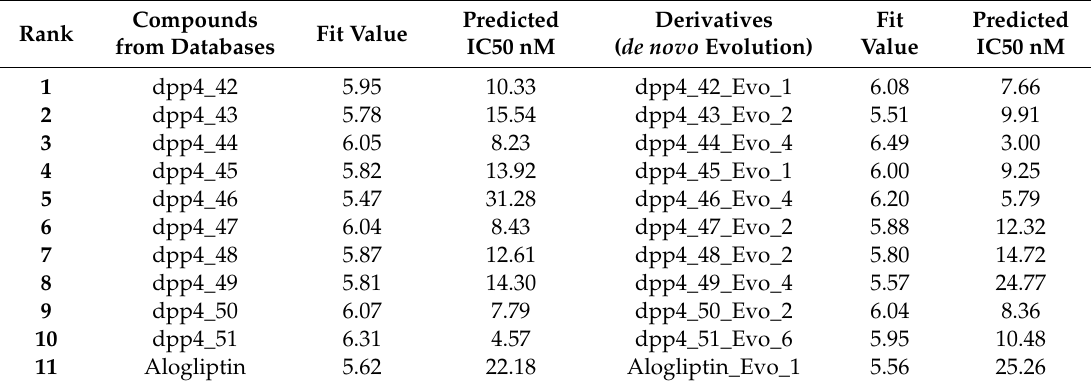
Table 5. Results of prediction activity of compounds from databases and their